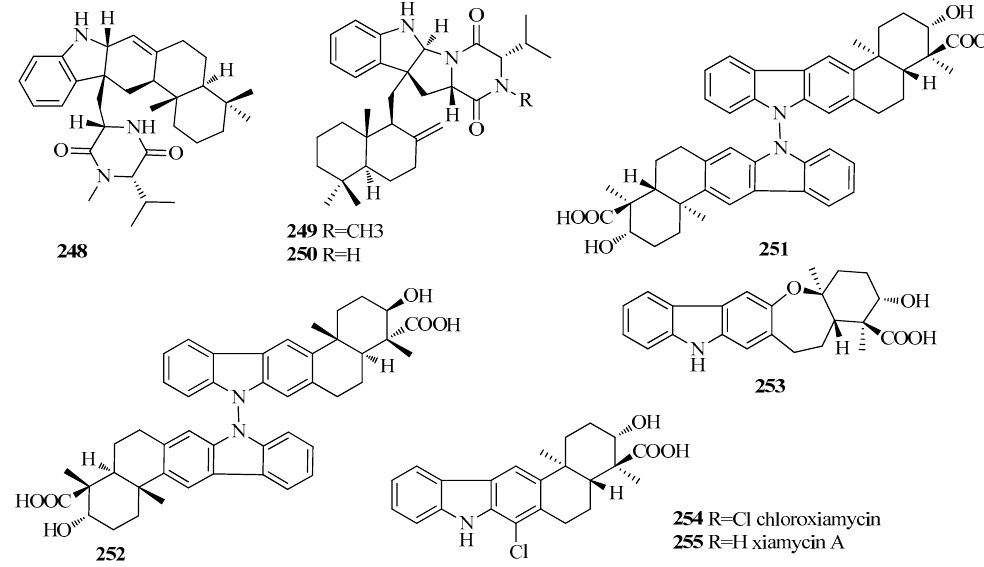
Figure 3. The friedo-drimane sesquiterpenoidskeletons ( I – XXI ) and three dimers. Table 2. Reported structures offriedo-drimane sesquiterpenoids.